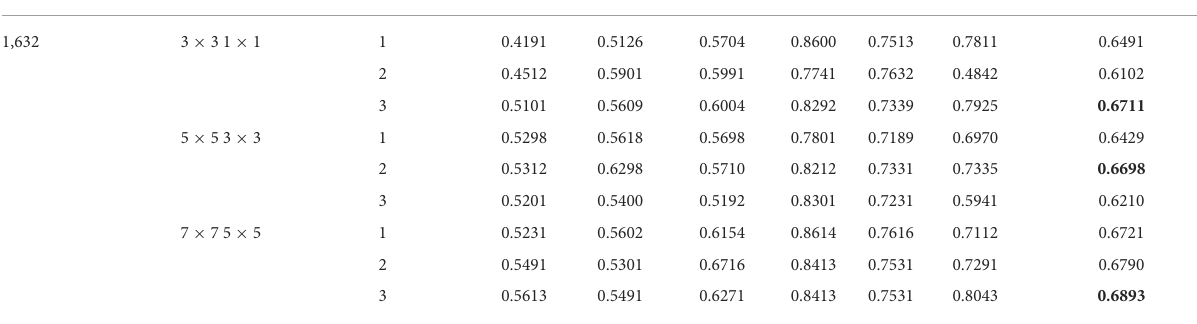
TABLE 6 Comparison of classification accuracy of multiple binary classifiers.